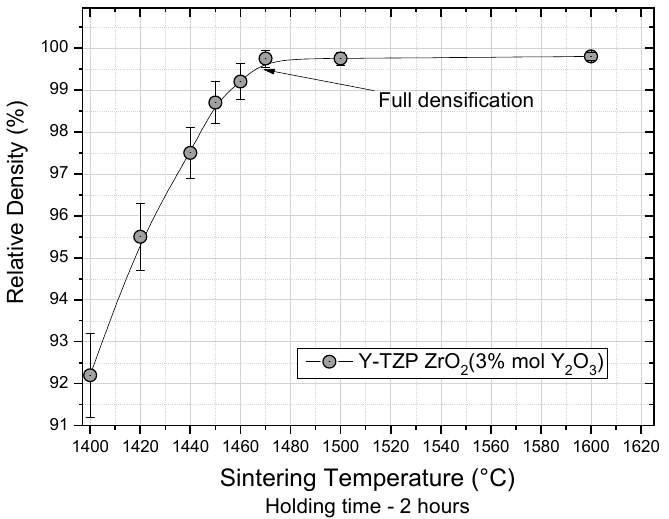
Figure 2. Relative density of sintered Y-TZP samples as a function of sintering temperature using an isothermal holding time of 2 h.